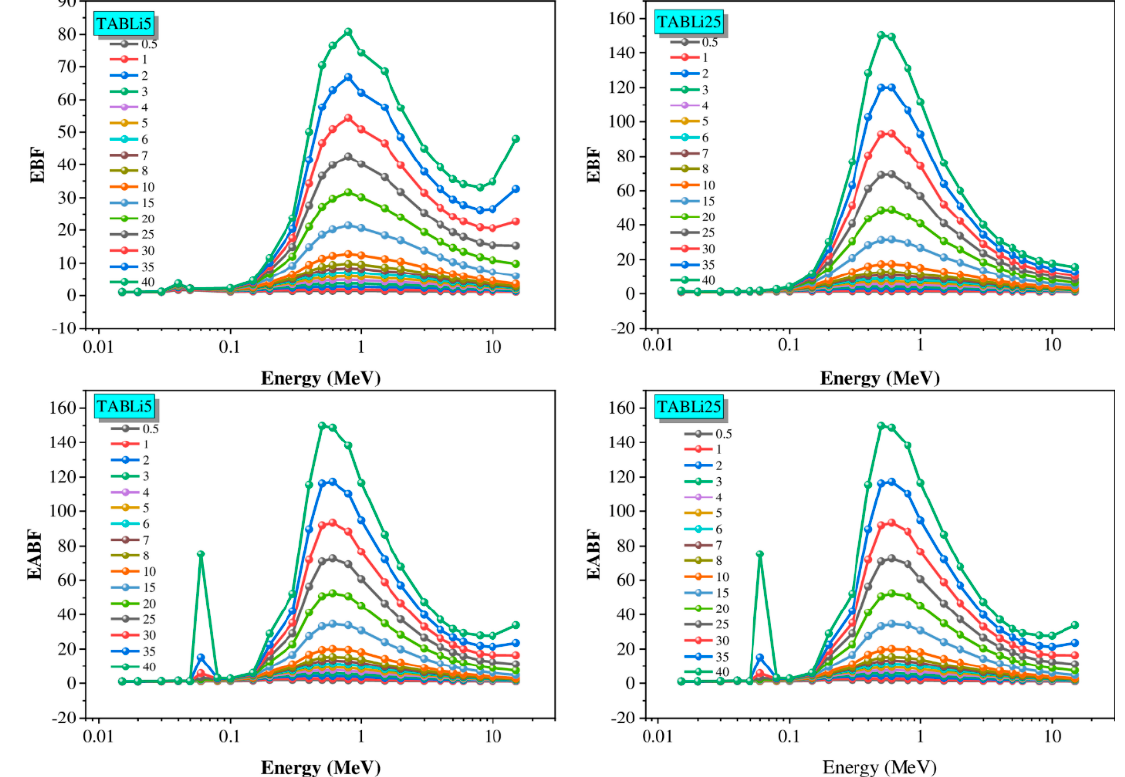
Figure 16. The buildup factorsversus the energy.